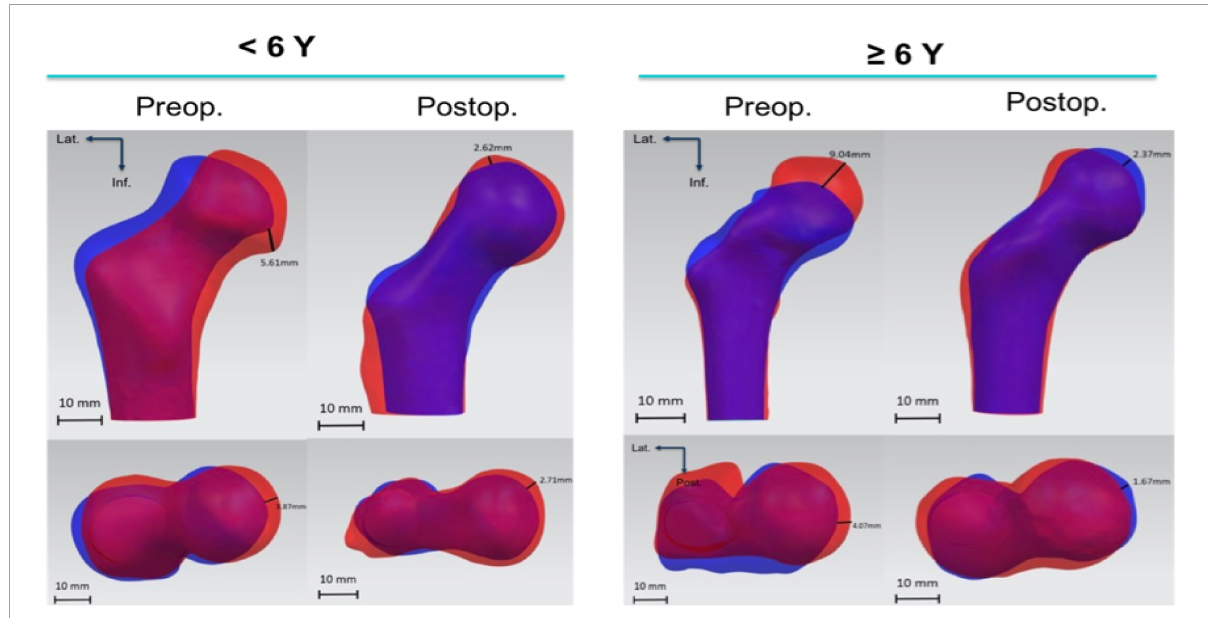
FIGURE7 Shape difference analysis of preoperative femoral computer-assisted design (CAD) models and the ones after removal of the IF. Blue silhouette stands for affected side and red silhouette contralateral side. The illustrated distance is the maximum value of distance between corresponding points on two models.